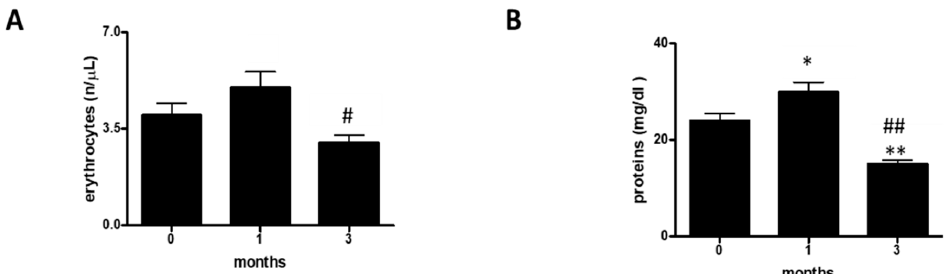
Figure 3. Hematuria and proteinuria. ( A ) assessment of erythrocytes at 0, 1, and 3 months in a group of 12 professional basketball athletes. The data are expressed as the mean ± SD. The significance was determined by the one-way ANOVA test: # ( p < 0.05) represents significance compared with one month. ( B ) assessment of proteins at 0, 1, and 3 months in a group of 12 professional basketball athletes. The significance was determined by the one-way ANOVA test: * ( p < 0.05) and ** ( p < 0.01) represent significance compared with 0 months; ## ( p < 0.01) represents significance compared with one month. The unit of measurement used is n / µ L (the number of bacteria or leukocytes or squamous cells in one microliter of